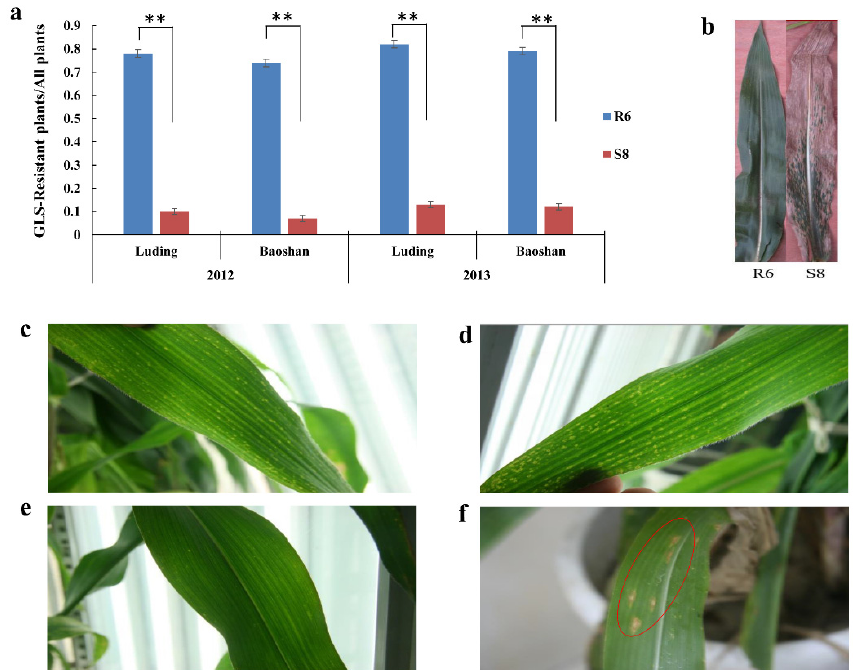
Figure 1. Disease resistance and symptoms of maize inbred lines R6 and S8 in response to C. zeina . ( a ) The disease resistance, here also known as GLS resistance, was evaluated 15 days after silking. Asterisks indicate significant differences between R6 and S8 (two-tailed Student’s t -test; **: p < 0.01). ( b ) Leaves of field-grown R6 and S8 infected by C. zeina . ( c , d ) R6 leaves’ performance before ( c ) and after ( d ) inoculation with C. zeina ; ( e , f ) S8 leaves before ( e ) and after ( f ) inoculation with C. zeina . The infected area is indicated by a red ellipse.